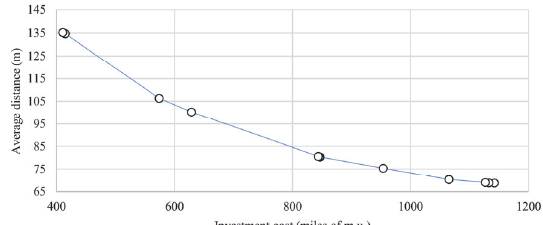
Fig. 3. Pareto front of the second scenario. Number of grid points = 20. Multi-objective approach = weighted-sum